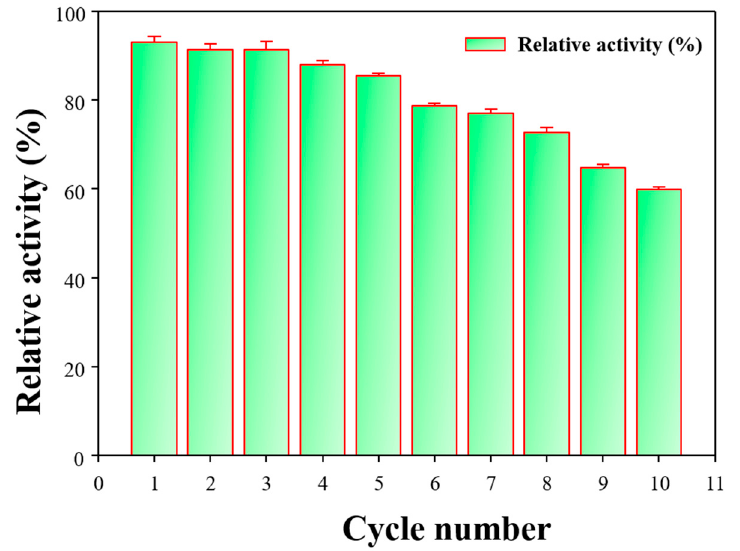
Figure 8. Repeated cycle bio-catalysis by HNTs-M-chitosan (1%)-GTA- Laccase.